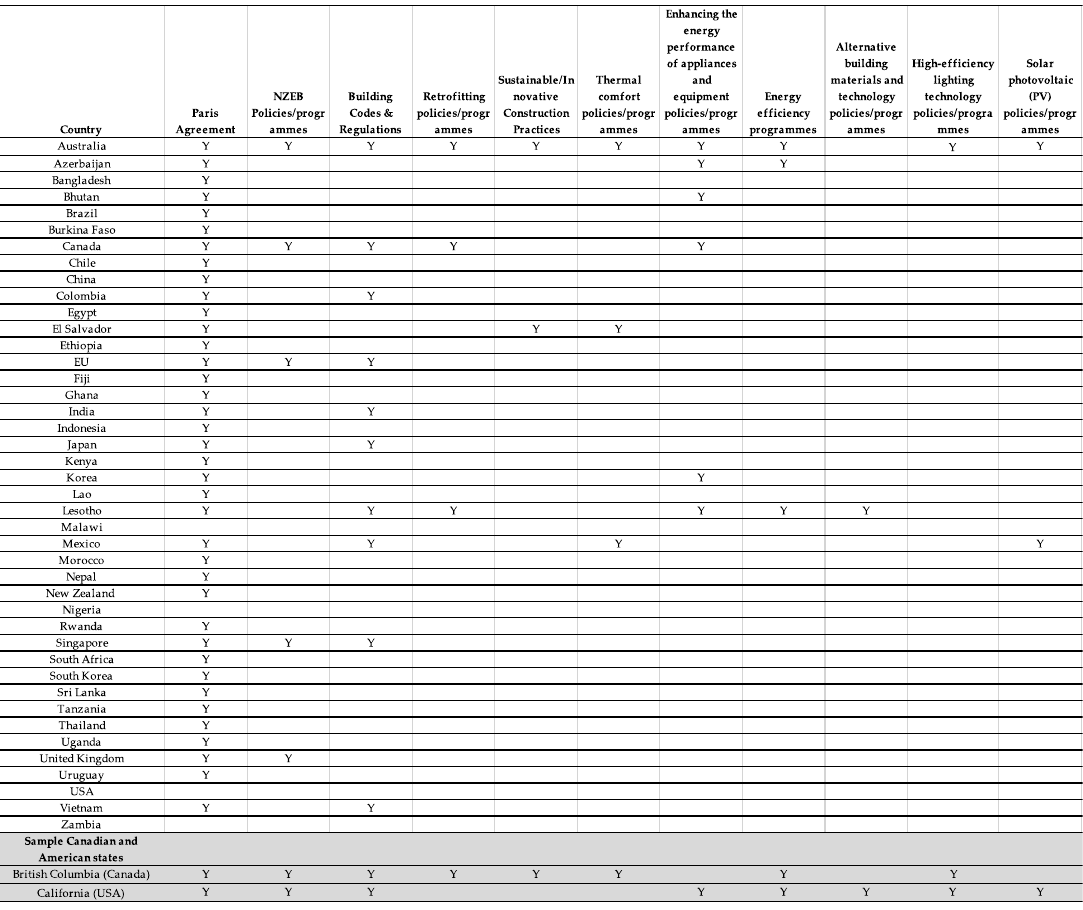
Table 1. Selected country/state status in relation to the Paris Agreement and built environment policies / programs.